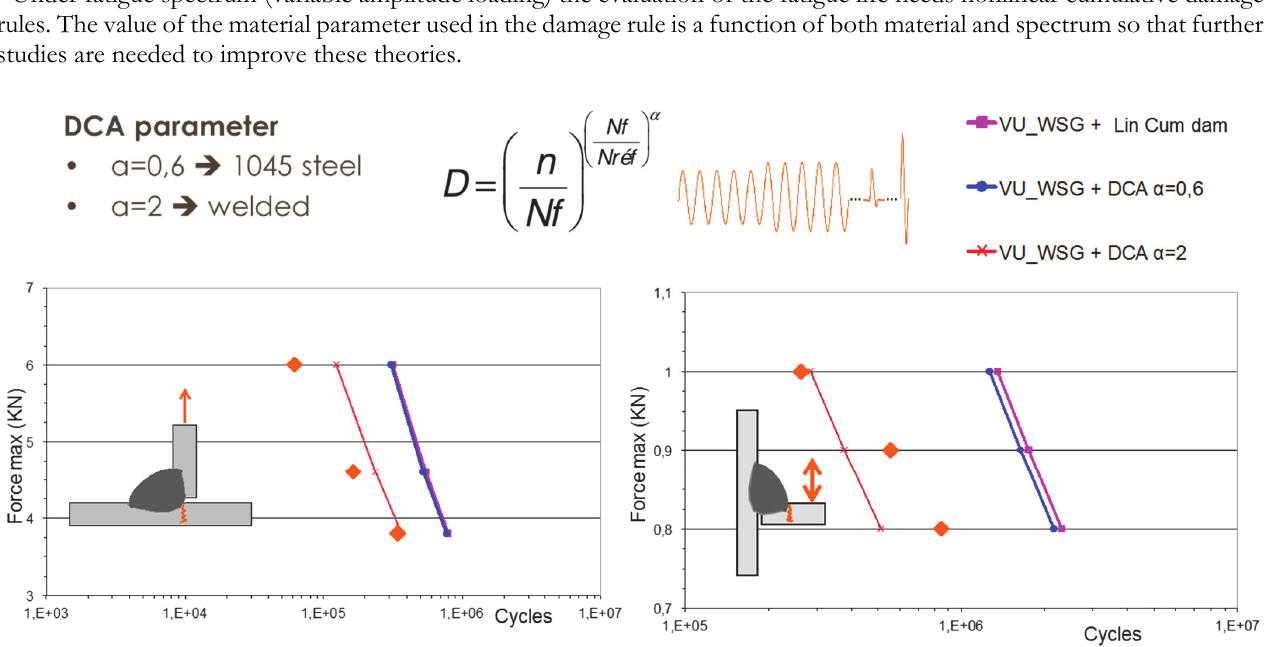
Figure 11: Comparison between linear and non-linear cumulative damage under tension and